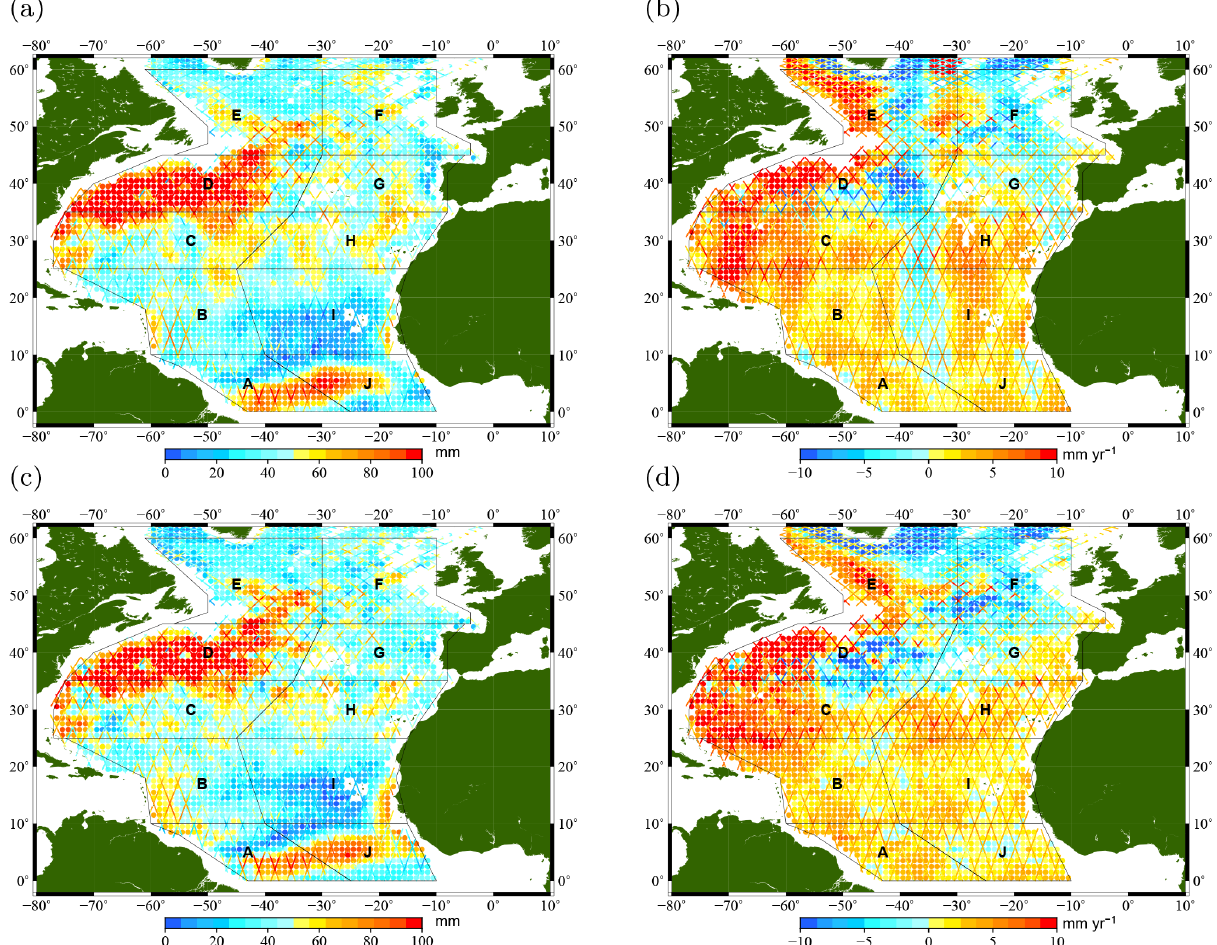
Figure 8. Amplitudes of the annual signal (left) and trends (right) computed of the sum of the components (Argo + GRACE) overlayed with those computed from the total sea level measured with altimetry. For the two top figures, the CSR96-DDK (a, b) solutions are used and for the bottom two, the CSR96-W (c, d) solution is